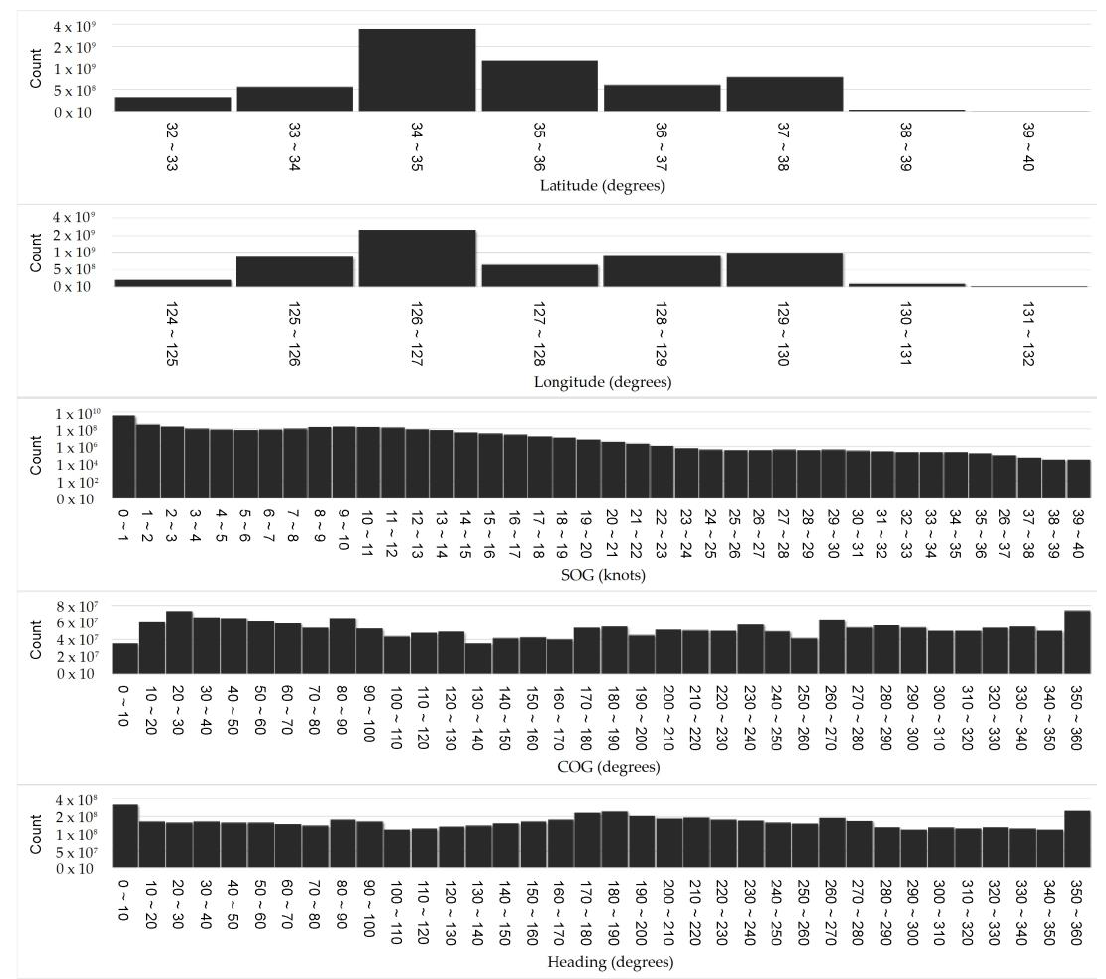
Figure 6. Ship dynamic-data distribution characteristics. Table 4. Statistical analysis results of AIS data after preprocessing.